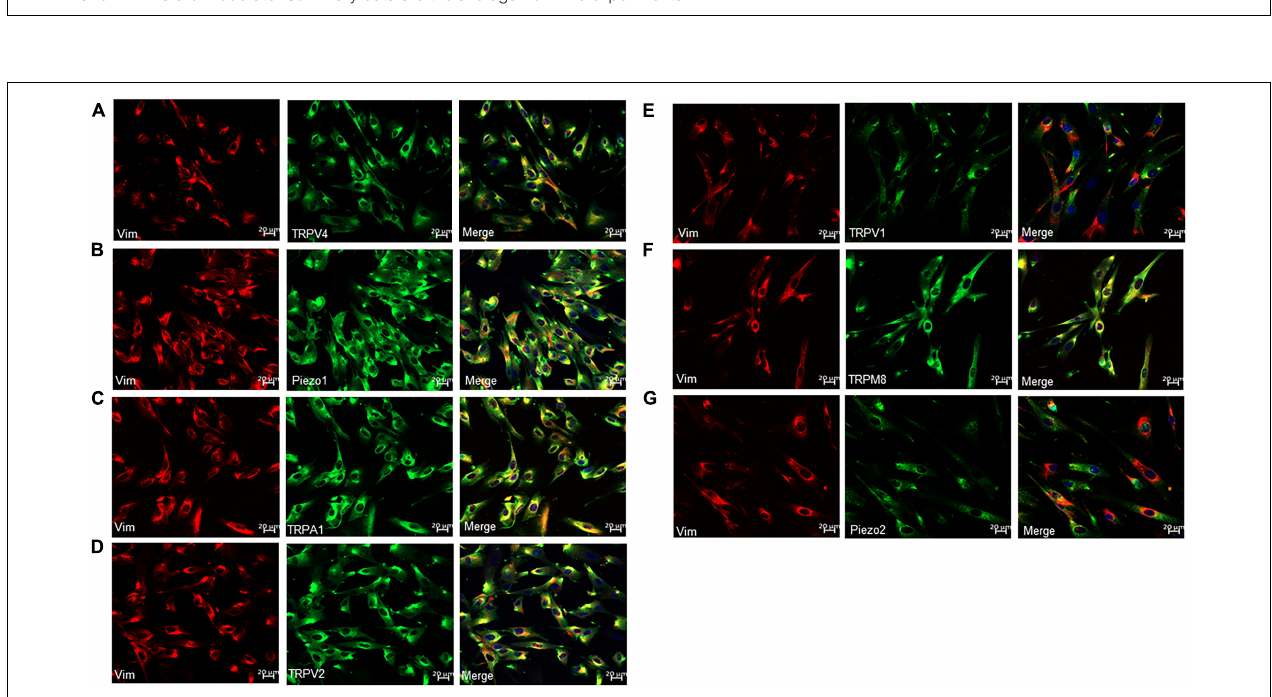
FIGURE 3 | Immunofluorescence for Vim (red) and TRP or Piezo channels (green) in cultured LP-ICs. Double staining reveals the protein expression of TRPV4 (A) , piezo1 (B) , TRPA1 (C) , TRPV2 (D) , TRPV1 (E) , TRPM8 (F) and Piezo2 (G) in most of the Vim+ LP-ICs. The nucleus marker (DAPI) is stained in blue.